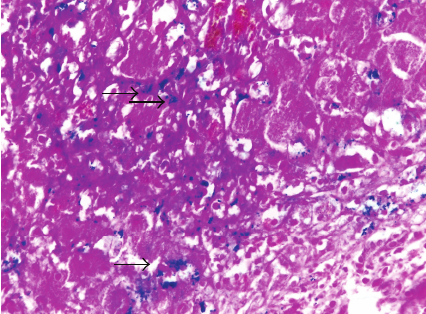
Figure 3: Moderate hemosiderosis: iron stores in reticuloendothe- lial cells, Perls stain, 400x. See arrows.